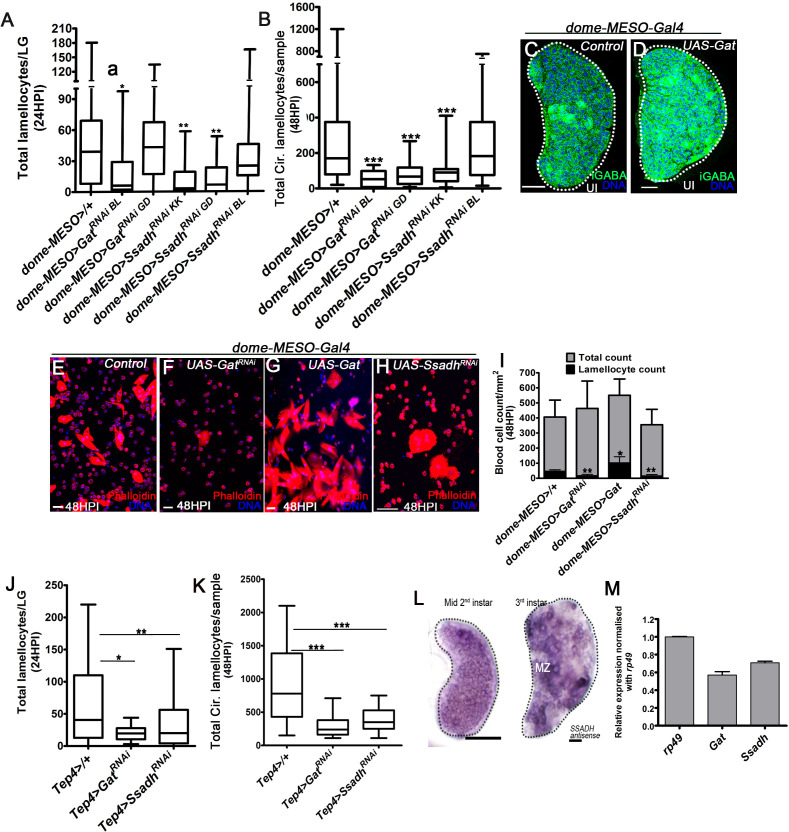
GABA uptake and its metabolism is important for lamellocyte formation.HPI is hours post wasp-infection. Scale bars in panels C, D And L = 20 µm and in panel E-H = 50 µm. In lymph gland, lamellocytes analyzed at 24HPI and in circulation at 48HPI. Graphs in panels (A, B, J and K), represents median in box plots and vertical bars represent upper and lowest cell counts and panels (i and m) represents mean ± standard deviation (mean ± SD). Statistical analysis in panels A, B, K and J is Mann-Whitney, two-tailed panel (I and M) is unpaired t-test, two-tailed and in. ‘n’ represents the total number of larvae analyzed, and for lymph glands ‘n’ represents lymph gland lobes analyzed. ns is nonsignificant. For better representation of the lymph gland primary lobes, the images shown, have been edited for removal of adjacent tissues (like dorsal vessel and ring gland). (A) Quantifications of progenitor-specific knock-down of Gat and Ssadh knock-down showing lymph gland lamellocyte numbers, dome-MESO-Gal4, UAS-GFP/+ (control, n = 39), dome-MESO-Gal4, UAS-GFP; UAS-GatRNAi BL (n = 15, *p=0.0238) dome-MESO-Gal4, UAS-GFP; UAS-GatRNAi GD (n = 36, ns), dome-MESO-Gal4, UAS-GFP; UAS-SsadhRNAi KK (n = 13, **p=0.0026), dome-MESO-Gal4, UAS-GFP; UAS-SsadhRNAi GD (n = 18, **p=0.0017) and dome-MESO-Gal4, UAS-GFP; UAS-SsadhRNAi
BL (n = 20, ns). (B) Quantifications of progenitor-specific knock-down of Gat, and Ssadh knock-down showing lamellocytes numbers in circulation, dome-MESO-Gal4, UAS-GFP/+ (control, n = 57), dome-MESO-Gal4, UAS-GFP; UAS-GatRNAi BL (n = 15, ***p<0.0001), dome-MESO-Gal4, UAS-GFP; UAS-GatRNAi GD (n = 15, ***p=0.007), dome-MESO-Gal4, UAS-GFP; UAS-SsadhRNAi KK (n = 22, ***p=0.0002), dome-MESO-Gal4, UAS-GFP; UAS-SsadhRNAi BL (n = 36, ns). (C, D) Lymph glands from (C) control (dome-MESO>GFP/+) uninfected larvae show punctated iGABA (green) staining in all blood cells of lymph gland while (D) larvae over-expressing Gat in progenitor cells (dome-MESO-Gal4, UAS-GFP; UAS-Gat) showed an increase in iGABA levels in blood cells. (E–H) In response to wasp-infection, compared to lamellocyte numbers detected in circulation of (E) control animals (dome-MESO-GFP>/+), progenitor-specific (F) expression of GatRNAi (dome-MESO-Gal4, UAS-GFP; UAS-GatRNAi) causes reduction in lamellocyte numbers, while (G) overexpression of Gat (dome-MESO-Gal4, UAS-GFP; UAS-Gat) leads to increased numbers and (H) expression of SsadhRNAi (dome-MESO-Gal4, UAS-GFP; UAS-SsadhRNAi) causes reduction. (I) Quantification of total circulating blood cell numbers per mm2 in animals at 48 HPI. Represented here are the numbers of lamellocytes (black bar) and total cell counts (gray bar) counted per mm2. No significant difference in overall cell density is detected, although a reduction in lamellocyte numbers is seen in dome-MESO-Gal4, UAS-GFP; UAS-GatRNAi (n = 5, **p=0.0026), and dome-MESO-Gal4, UAS-GFP; UAS-SsadhRNAi (n = 5, **p=0.0019) and an increase is seen in dome-MESO-Gal4, UAS-GFP; UAS-Gat (n = 5, *p=0.0214) in comparison to dome-MESO-Gal4, UAS-GFP/+ (control, n = 5). (J) Total lamellocyte quantification per lymph gland. Tep4-Gal4, UAS-mCherry/+ (control, n = 54), Tep4-Gal4, UAS-mCherry; UAS-GatRNAi (n = 16, *p=0.0191), Tep4-Gal4, UAS-mCherry; UAS-SsadhRNAi (n = 68, **p=0.0065). (K) Total circulating lamellocyte quantification per sample. Tep4-Gal4, UAS-mCherry/+ (control, n = 33), Tep4-Gal4, UAS-mCherry; UAS-GatRNAi (n = 16, ***p<0.0001), Tep4-Gal4, UAS-mCherry; UAS-SsadhRNAi (n = 34, ***p<0.0001). (L) Representative in situ hybridization images showing Ssadh mRNA expression in lymph gland from mid-2nd and 3rd instar control larva. Uniform expression is detected in all cells in early time-points. Later the expression is comparatively elevated within the prospective progenitor compartment (medullary zone, MZ). (M) Relative mRNA expression of Gat and Ssadh from RNA extracted from 3rd instar wild-type larval lymph glands. The levels are normalized to rp49 CT values.Figure 2—figure supplement 2—source data 1.Contains numerical data plotted in Figure 2—figure supplement 2A,B,I,J,K and M.